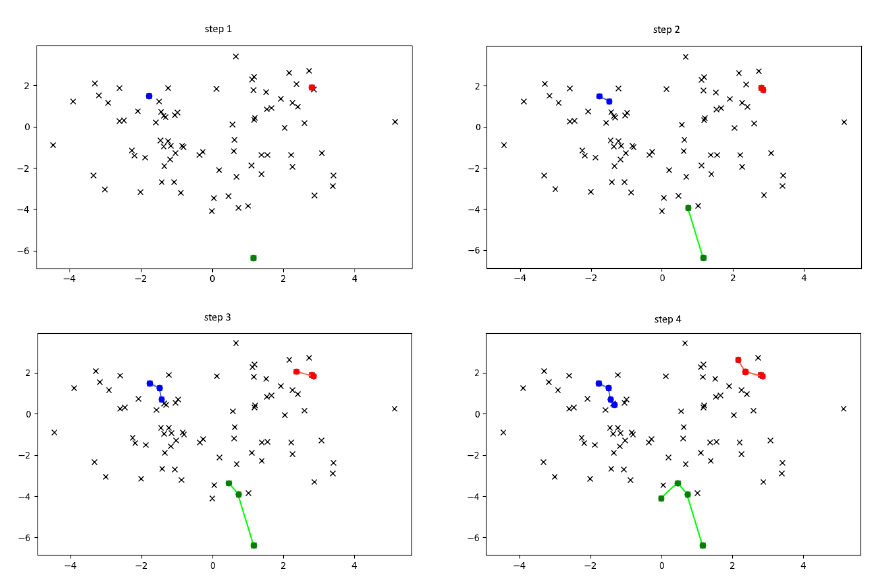
Figure 1. Example behaviour of four individuals randomly initialized in a small dataset during first four